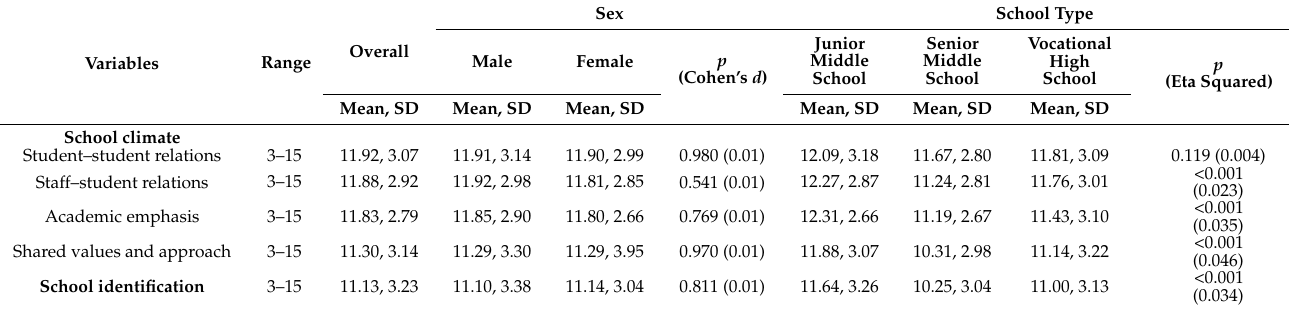
Table 3. Subgroup analysis by sex and school